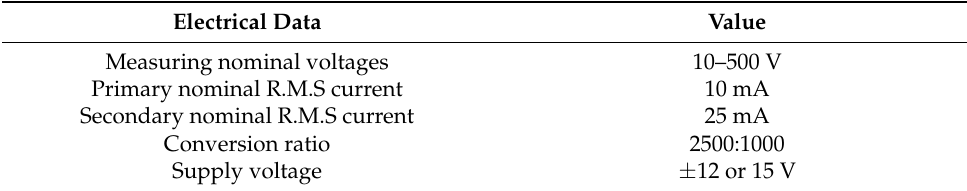
Table 2. LV 20-P sensor characteristics